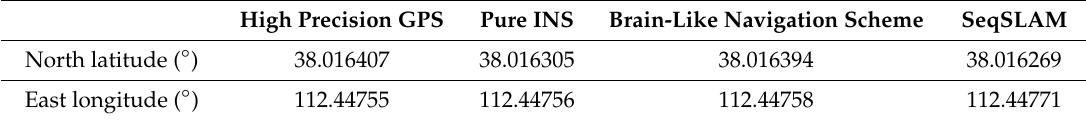
Table 6. Coordinates at terminus of experiment 2.